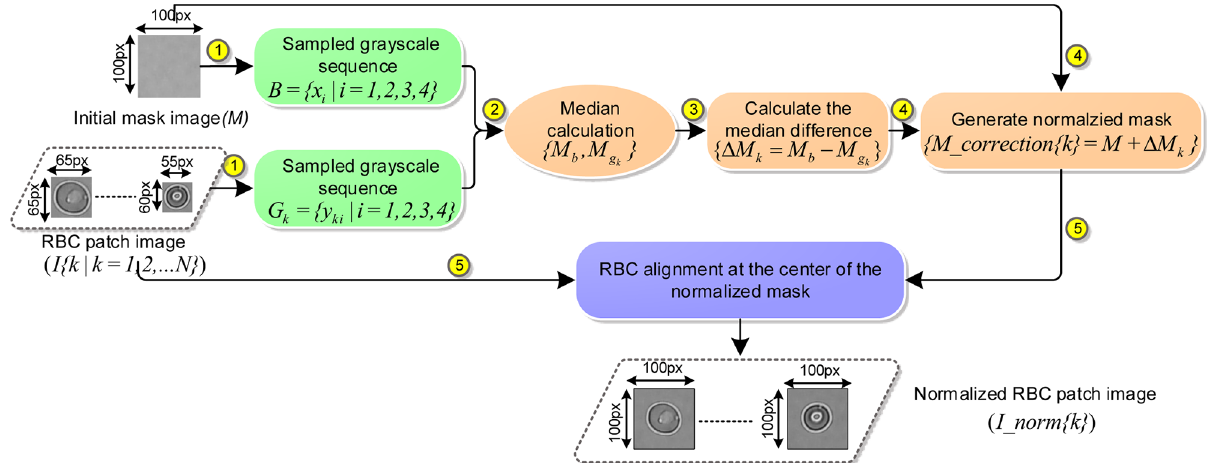
Fig 5. Workflow of the size-invariant (100px * 100px) RBC patch normalization. Steps 1-5 are describedin the text.